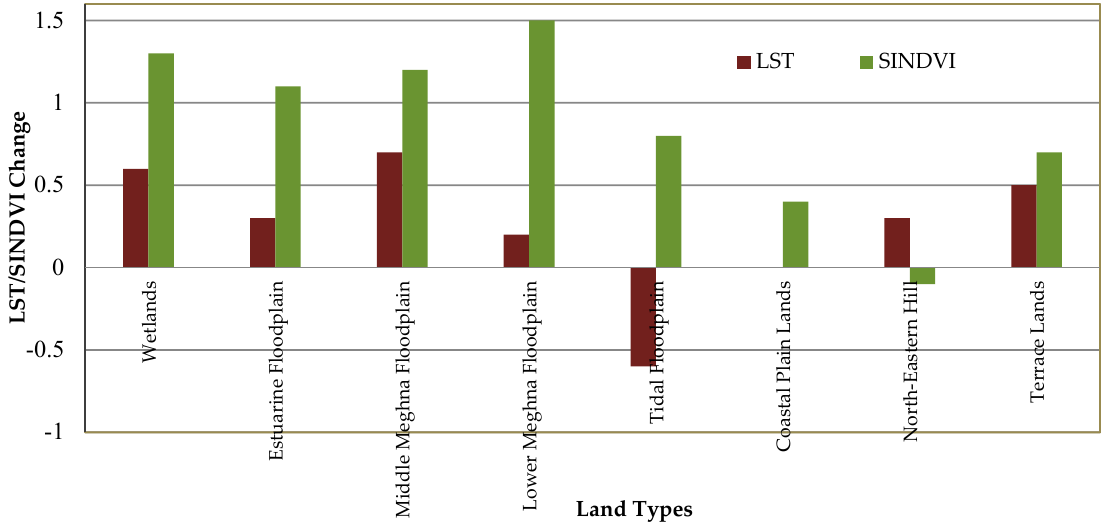
Figure 10. Geospatial relations of LST and SINDVI range by mean value average.